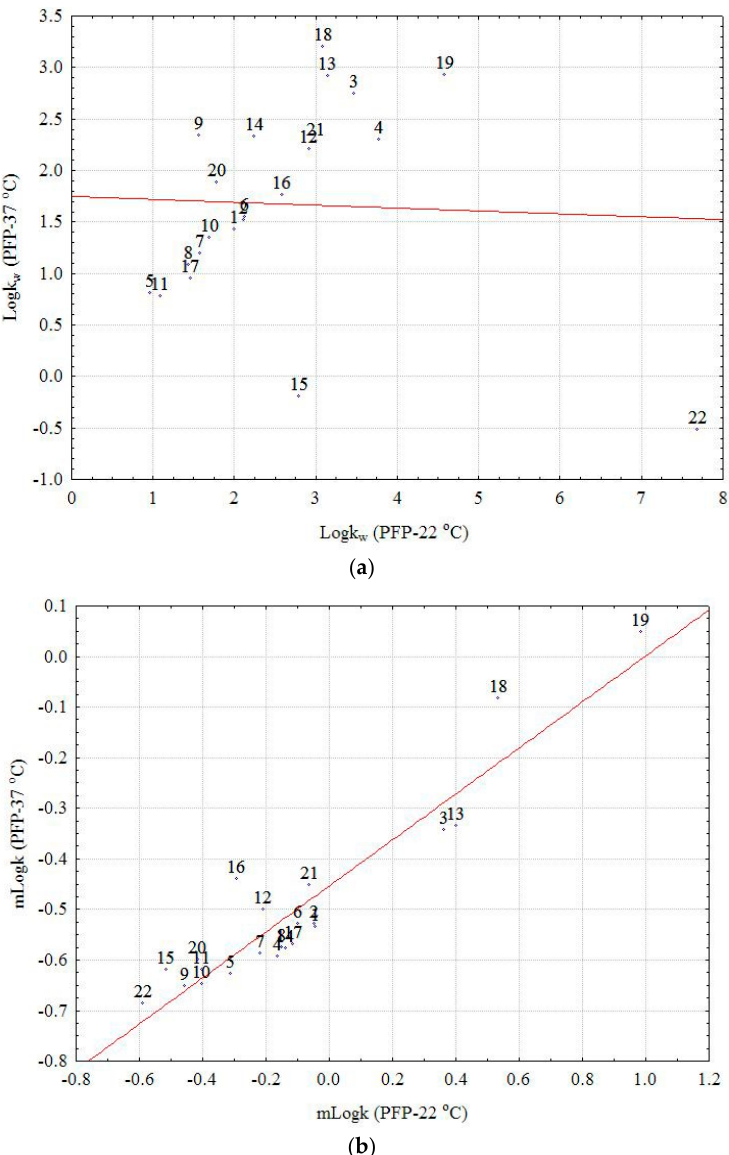
Figure 1. Scatterplot of logkw values corresponding to PFP column at 22 °C ( a ) and 37 °C; and m logk , respectively ( b ).